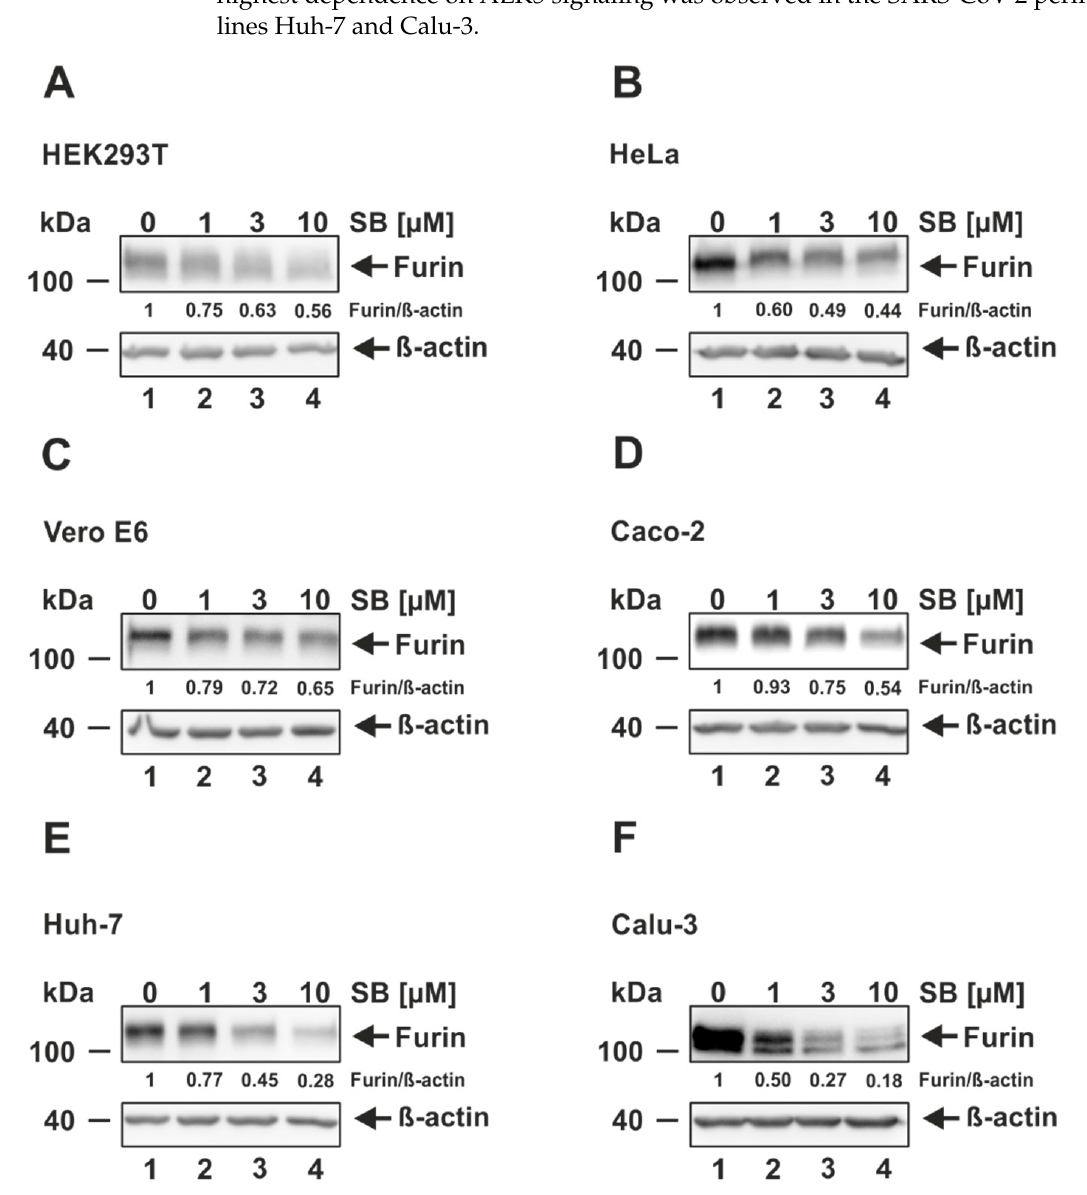
Figure 3. Decrease of furin expression by the ALK5 inhibitor SB431542. ( A ) HEK293T, ( B ) HeLa, ( C ) Vero E6, ( D ) CaCo-2, ( E ) Huh-7, and ( F ) Calu-3 were incubated for 24 h with the indicated concen- trations of SB431542 (SB) or the solvent control DMSO (0 µ M). Western Blot analyses were performed to detect furin and ß-actin. Protein levels of furin and ß-actin were quantified via densitometric analyses utilizing the Image Lab Software. Protein levels without SB (0 µ M) were set to 1.